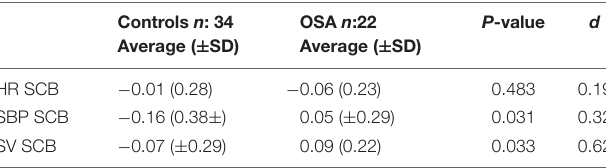
TABLE 3 | Standardized coefficient β of consecutive pulse waves versus hemodynamic parameter. Controls n : 34 Average ( ±